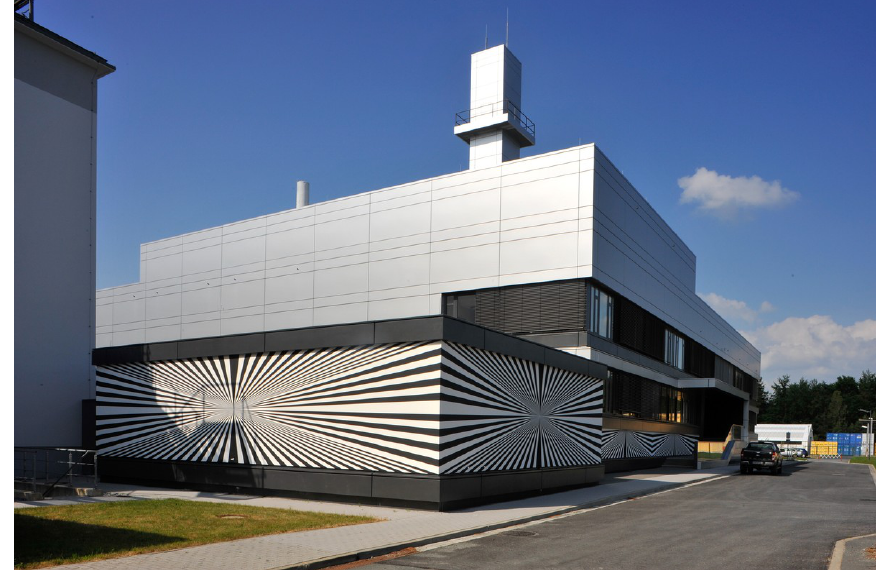
Figure 1. Impression of the Center for Radiopharmaceutical Tumor Research. The vault of the cyclotron is shown in the front. Picture: HZDR/Frank Bierstedt.